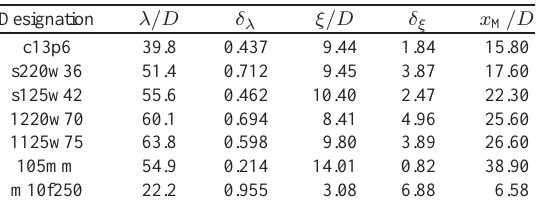
Table 2 Blast parameters for the point source and energy efflux models